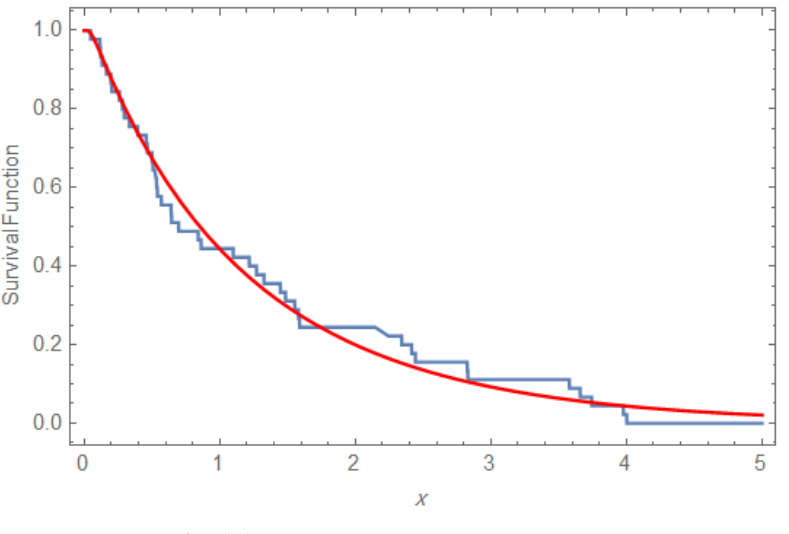
Figure 3. Fitness of real